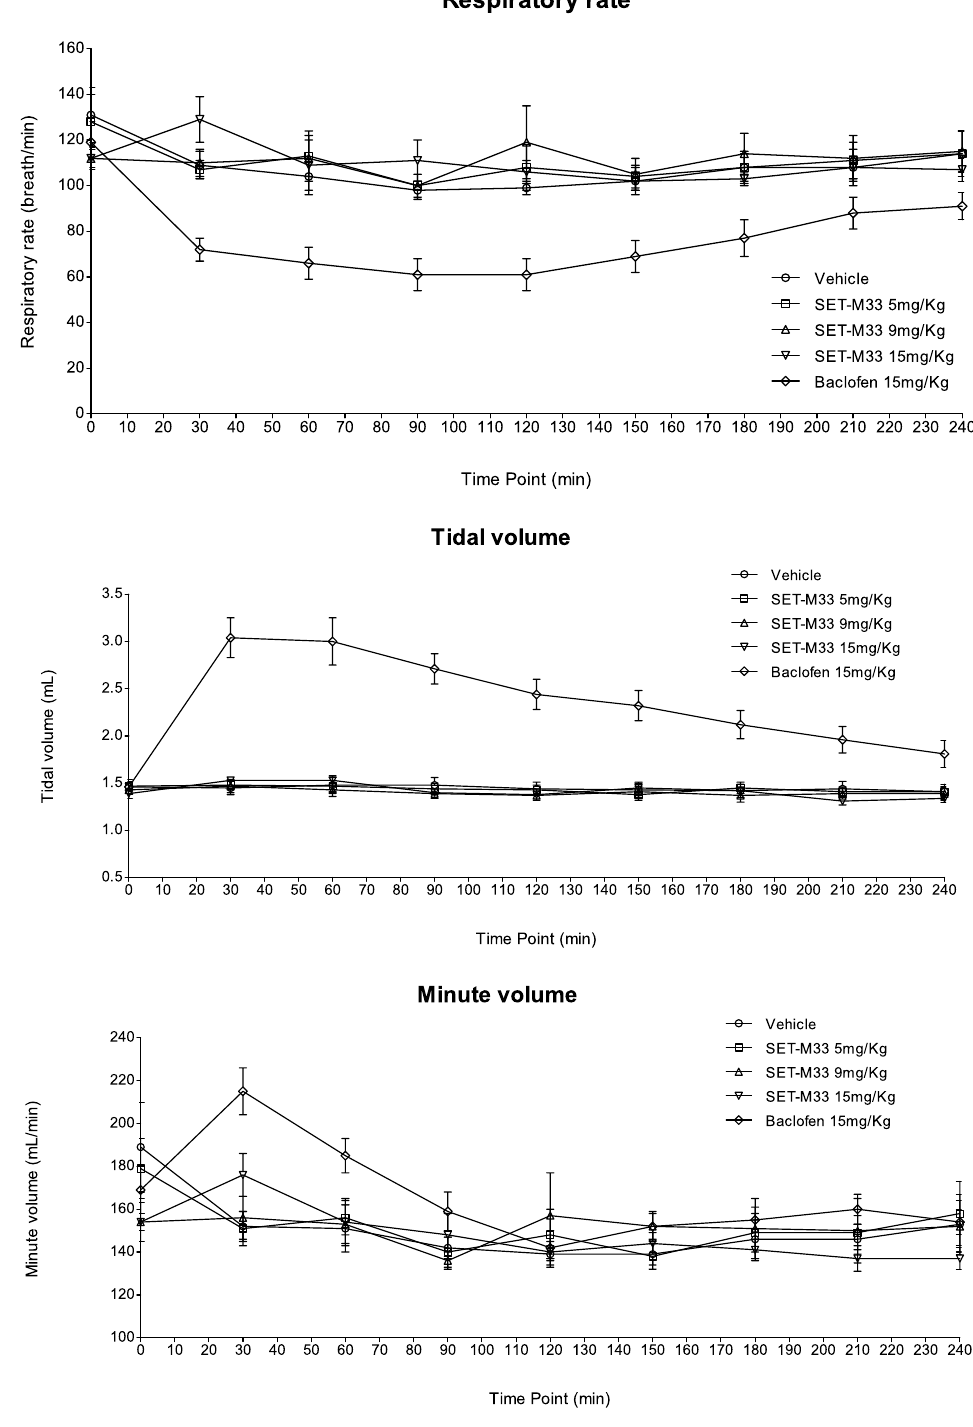
Figure 1. Effects of intravenous injection of SET-M33 at 0 (vehicle), 5, 9 and 15 mg/kg on respiratory rate (breaths/min ± se), tidal volume (mL ± se) and minute volume (mL/min ± se) in rats. Baclofen at 15 mg/day was used as positive control. se standard error of mean. Symbols (triangle, circle, rhombus or square) indicate a group mean respiratory parameter. The bar represents the standard error. The graphs were obtained using GraphPad Prism for Windows version 5.03, GraphPad Software, San Diego, California USA, www. graph pad. com. The groups treated with SET-M33 peptide were compared to vehicle using Williams’ test. The comparison between positive control and vehicle were made using two-tailed t test based on the error mean square from the analysis of